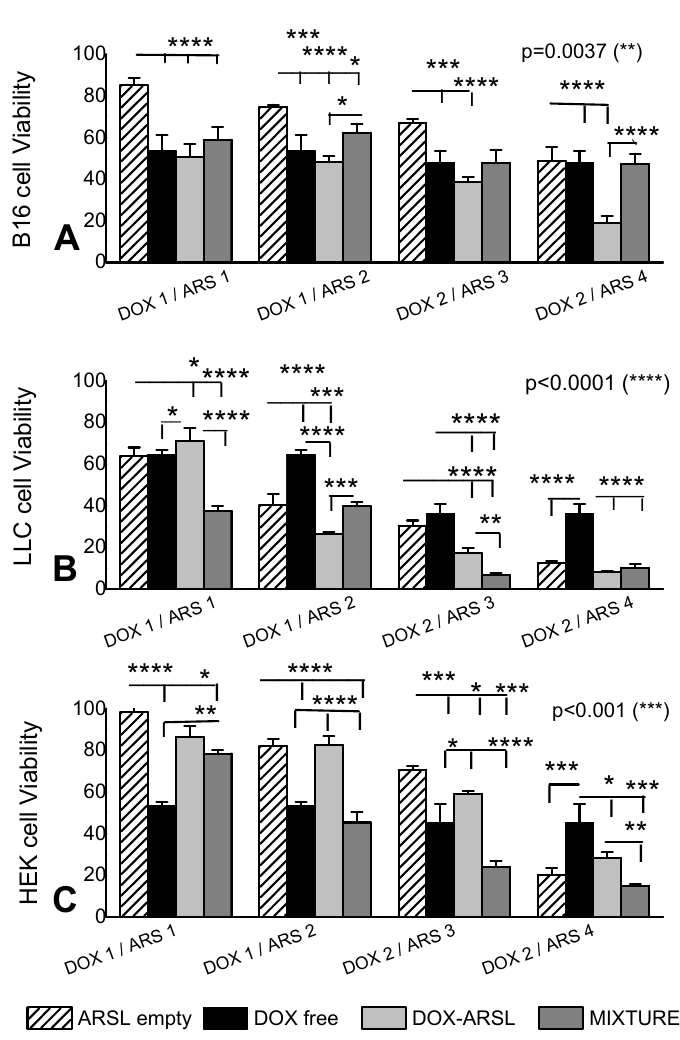
Figure 7. Viability of cells after incubation with DOX-ARSL (and control liposomes and compounds) for 24 h. ( A ) B16 cells; ( B ) LLC cells. ( C ) HEK cells. *, **, *** and **** correspond to p < 0.05, p < 0.01, p